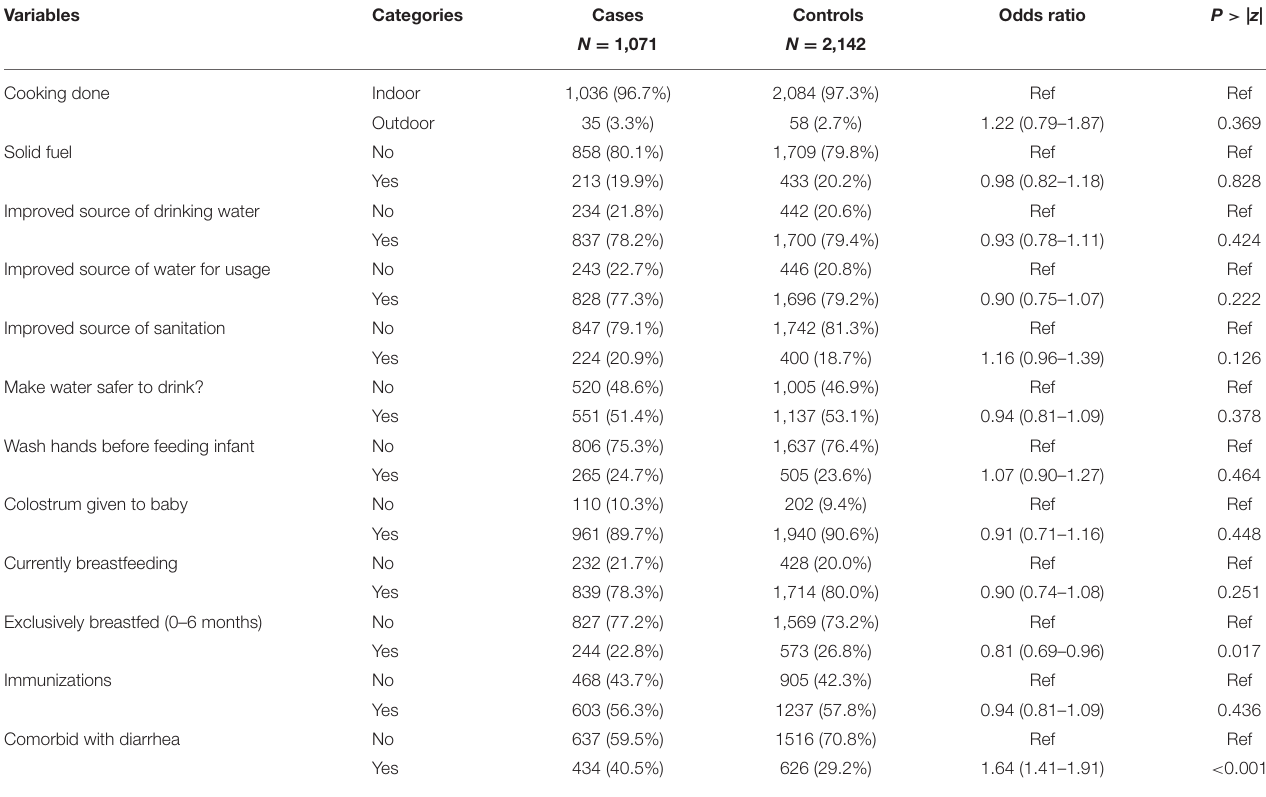
TABLE 3 | Descriptive and univariate analysis of household behavioral and WASH practices, and health and nutrition of participants with